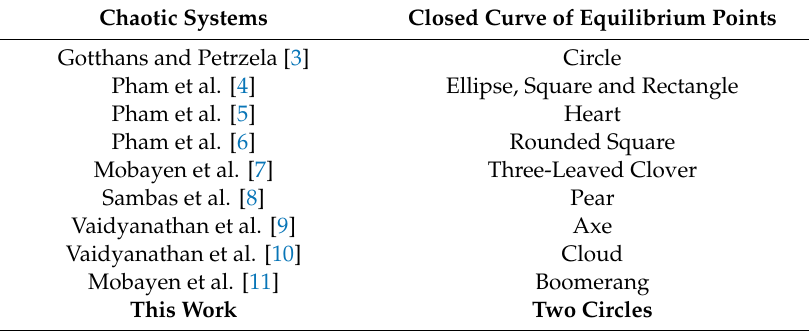
Table 1. Chaotic systems with a closed curve of equilibrium